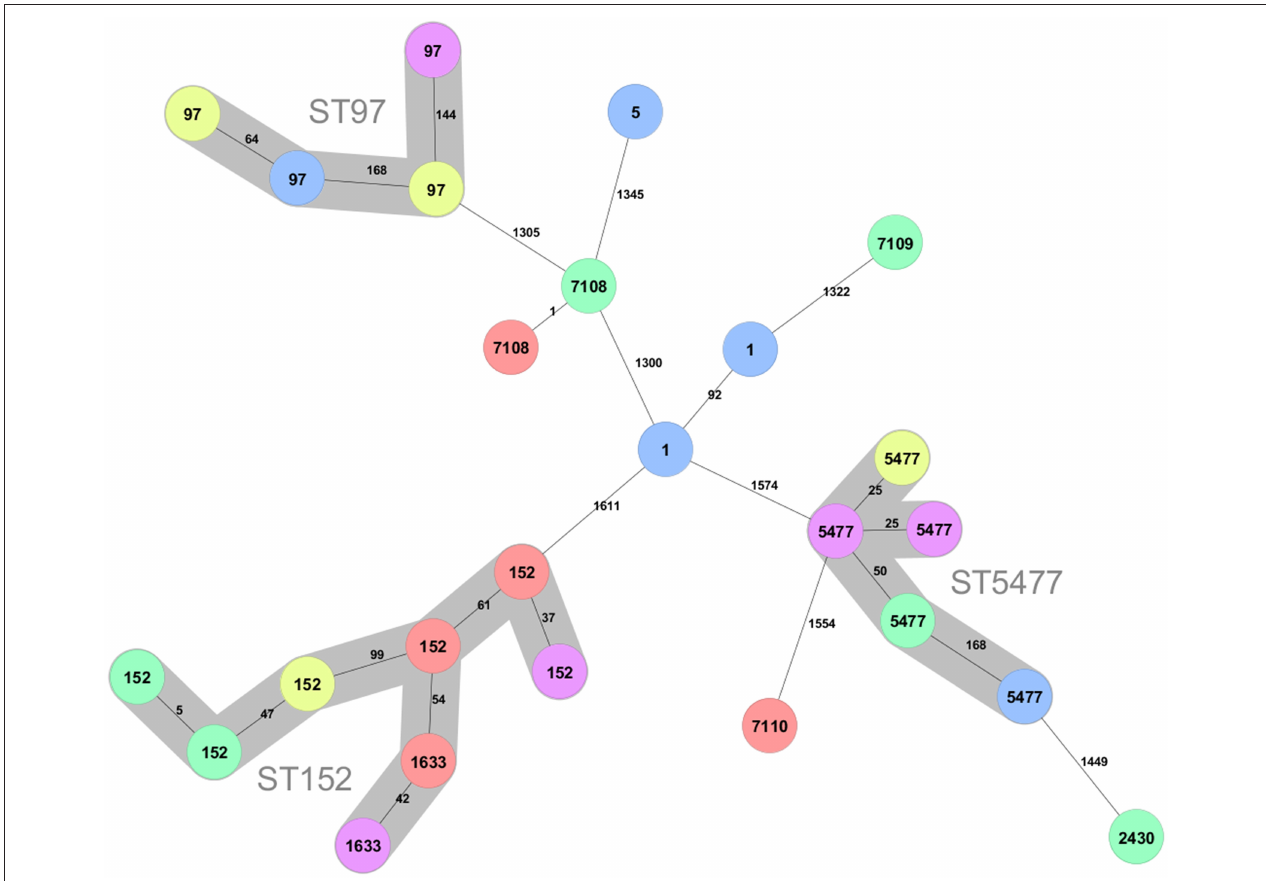
FIGURE 1 | Minimum spanning tree created for the 25 S. aureus strains from the Kigali (yellow), Eastern (red), Western (pink), Northern (green), and Southern (blue) province of Rwanda. The tree was created using 1,692 loci. Clusters connecting isolates with less the 200 different loci are indicated with background colors and named with the ST number in the cluster. The ST of the isolates are shown on the nodes and the number of different alleles between pairs of isolates are shown at the connecting